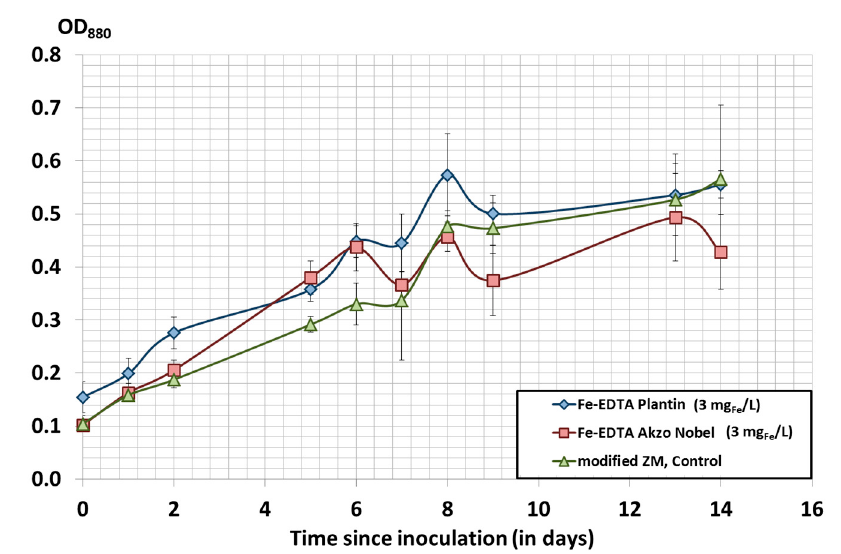
Figure 6. OD 880 measurements of Spirulina grown using Fe-EDTA from Plantin at 3 mg Fe /L (blue diamonds), Fe-EDTA from Akzo-Nobel at 3 mg Fe /L (red squares) and modified ZM (control, 2 mg Fe /L in the form of FeSO 4 ,6H 2 O with 50 mg/L of EDTA, green triangles), in duplicate. Error bars are standard deviations of the biological duplicates.